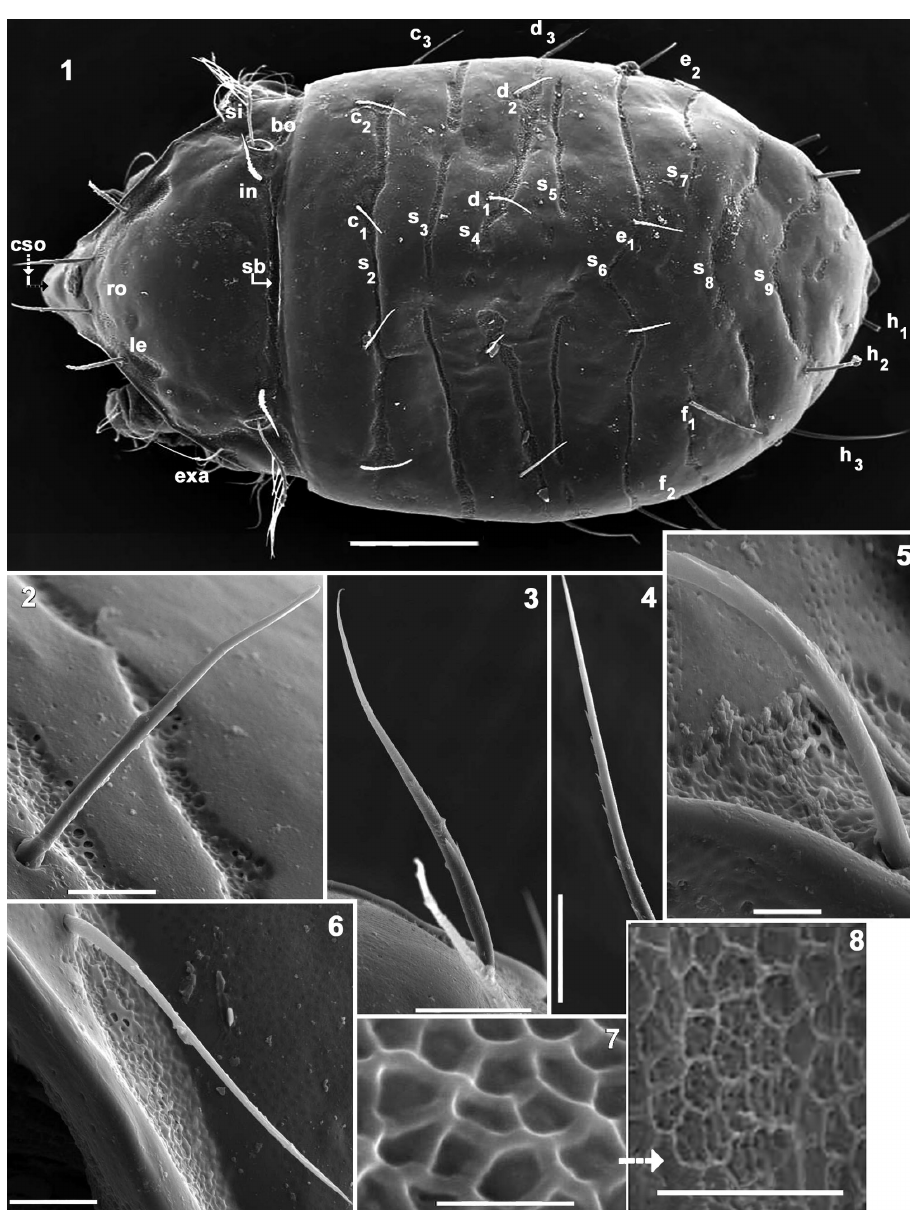
Figures 1–8. Mixacarus turialbaiensis sp. n. Adult with cerotegumental layer. SEM. 1 dorsal view 2 no- 3 ro setae 4 in setae 5 exa setae 6 exp setae 7 detail of cuticular microsculpture 8 polyhe- togastral setae d 3 dral microsculpture from porose area. Abbreviations: See Material and methods. Scale bars: 1 = 100 μm; 2 = 20 μm; 3 = 10 μm; 4 = 20 μm; 5 = 5 μm; 6 = 10 μm; 7 = 2 μm; 8 = 5